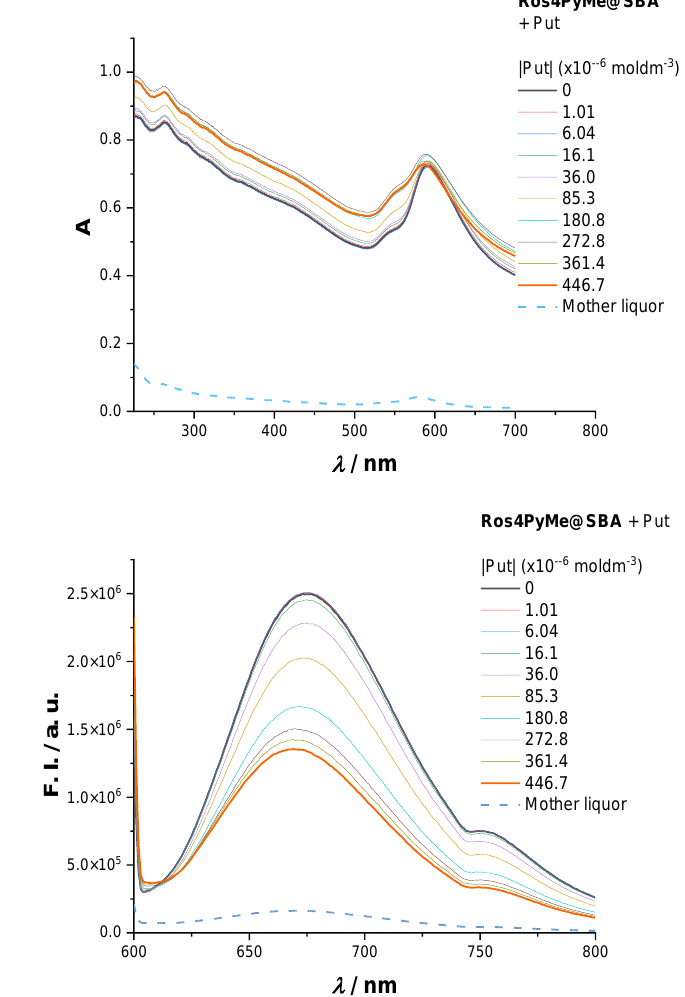
Figure 6. Absorption ( a ) and emission ( b ) spectra of Ros4PyMe@SBA with increasing amounts of putrescine (up to 4.47 × 10 − 4 moldm − 3 ) in water at 25 °C. Table 4. F. I. variation of the composites—Ros4PyMe@RHA, Ros4PyMe@TRHA, and